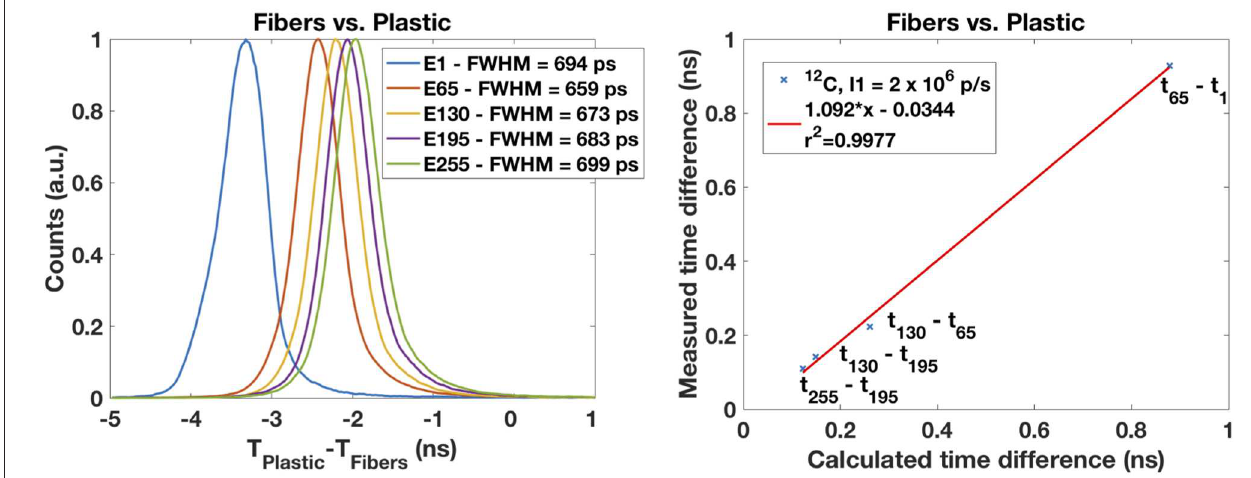
FIGURE 8 | (Left) Time resolution determined from the time between the arrival from carbon ions to the plastic detector and to the scintillating fibers. A reproducible value of 0.7 ns is observed for five energy steps covering the full energy range. The energy steps E 1 , E 65 , E 130 , E 195 , and E 255 correspond to 88.8, 197.6, 276.1, 346,4, and 430.1 MeV/u, respectively. (Right) The higher the energy, the faster the particles and the smaller the time elapsed between detectors. If one takes the distance between the detectors of 27.5 cm, the change in δ t = t E ′′ − t E ′ is consistent with the energy change.